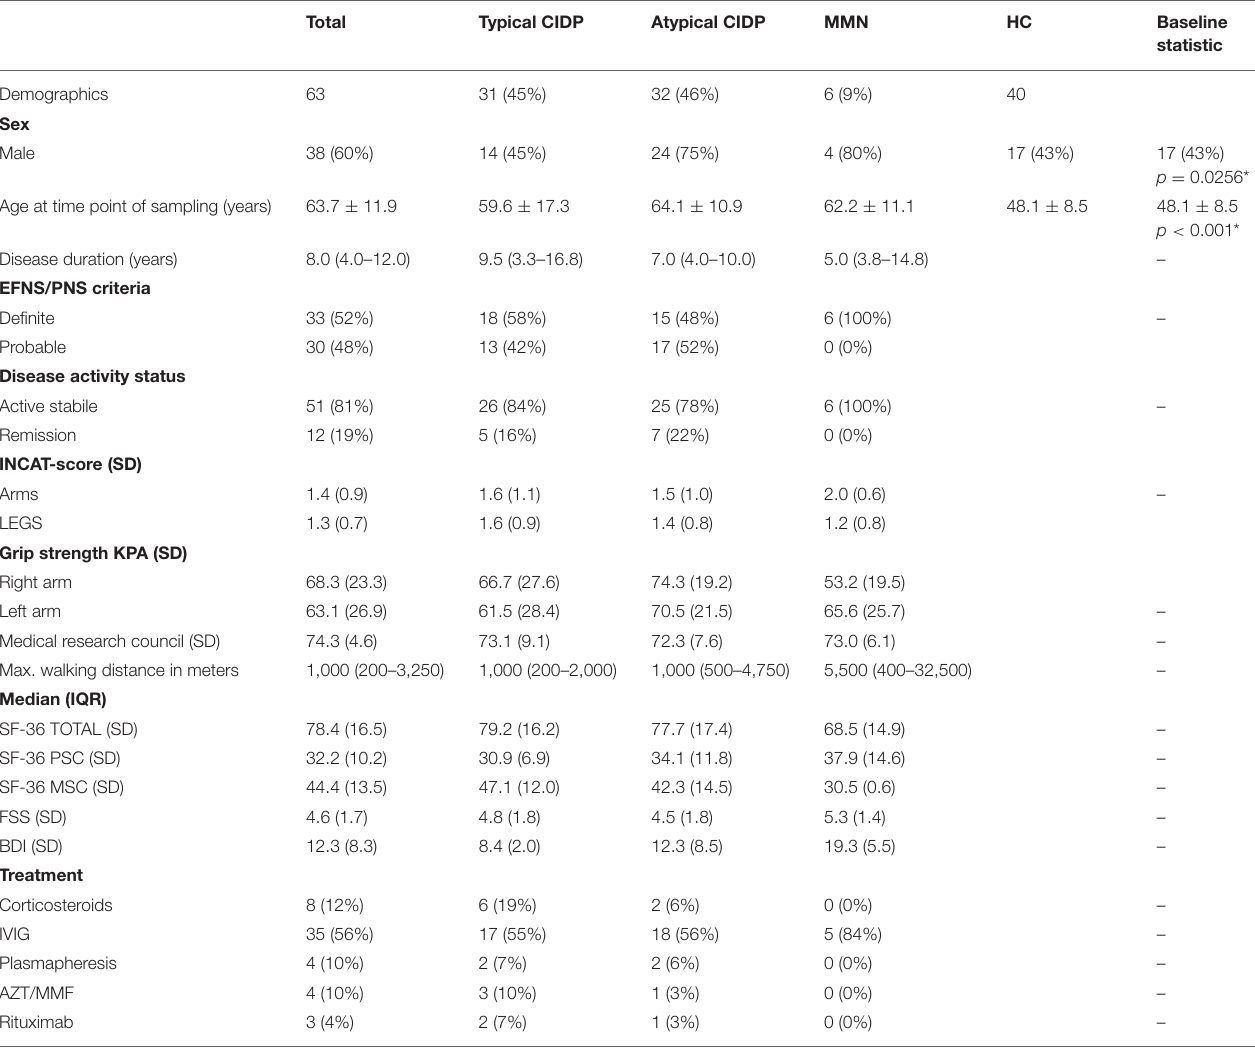
TABLE 1 | Patient